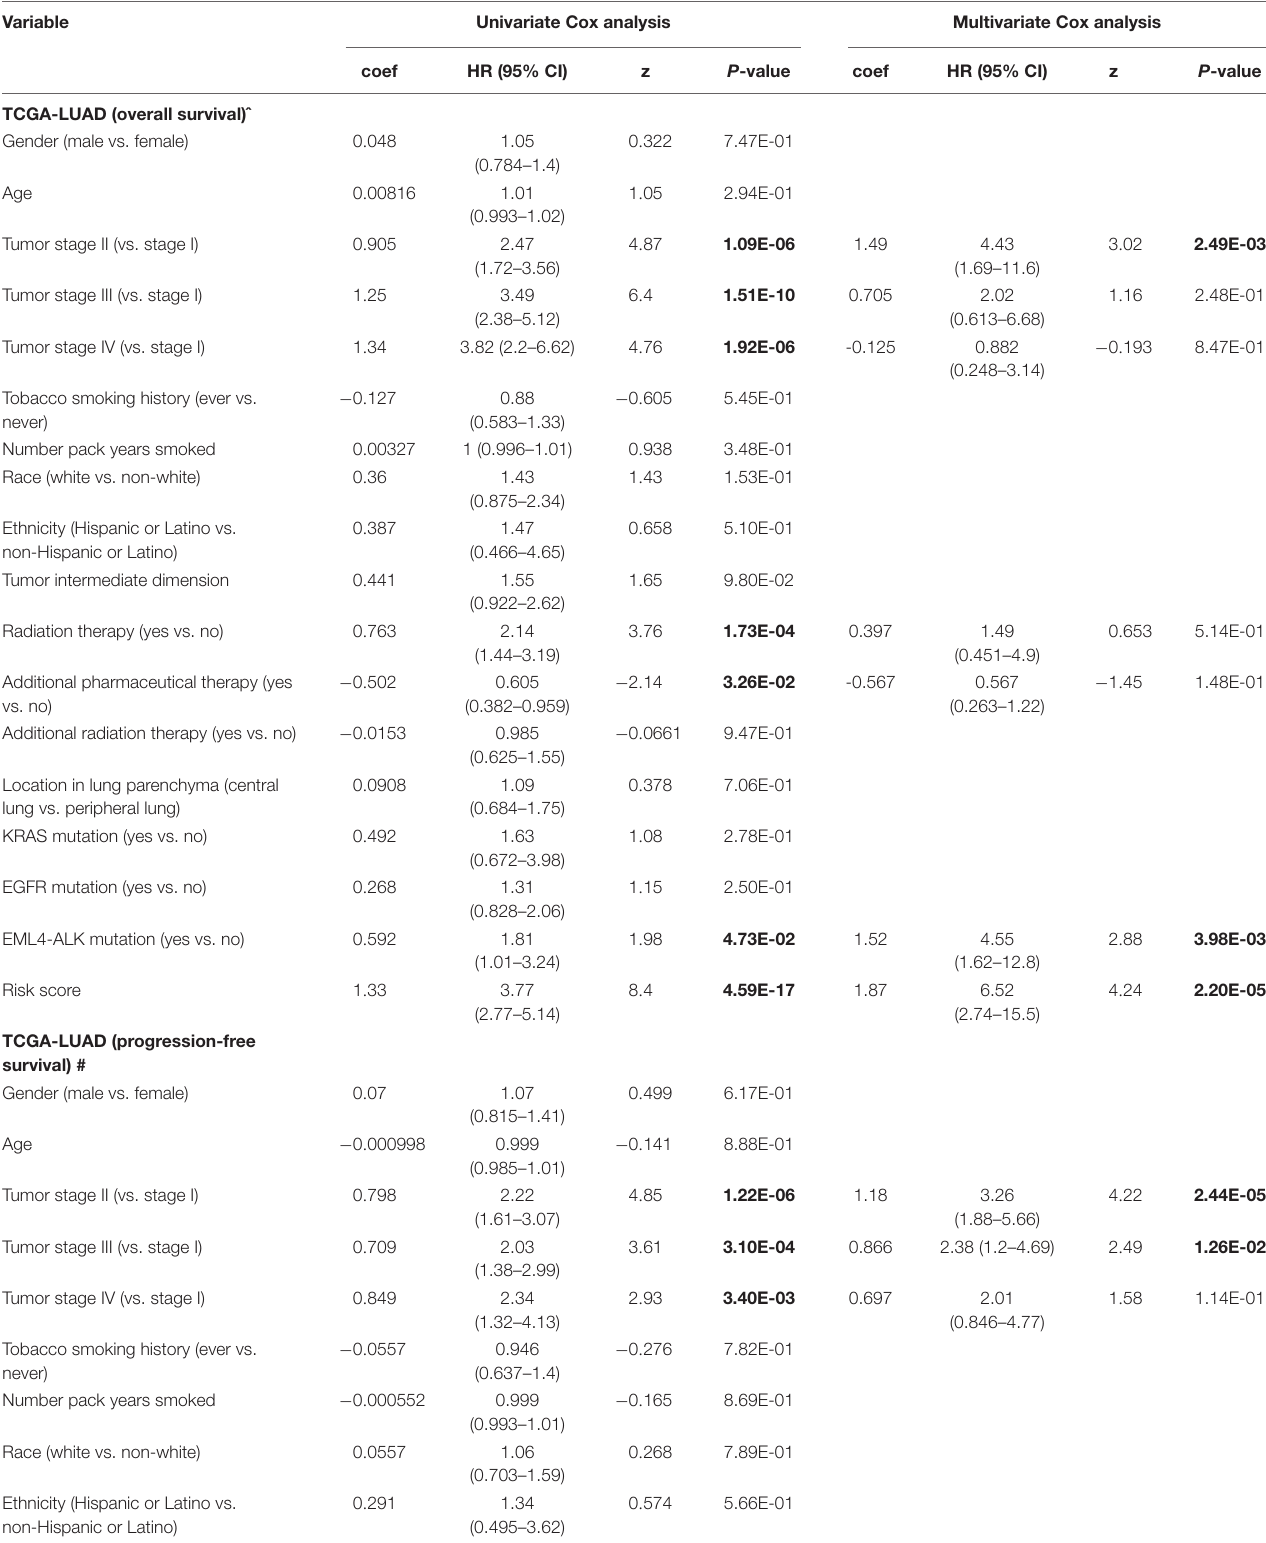
TABLE 4 | Univariate analysis and multivariate analysis of the correlation of gene-signature risk score with outcomes among lung adenocarcinoma patients in three cohorts*. Variable Univariate Cox analysis Multivariate Cox